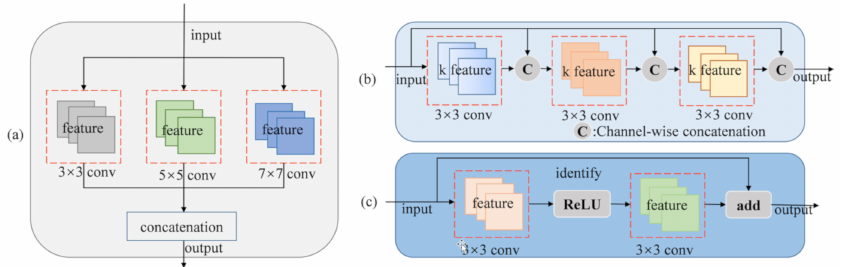
Figure 2. Di ff erent blocks neural network units. ( a ) Inception block; ( b ) dense block (layer = 3, k = 3); ( c ) residual block